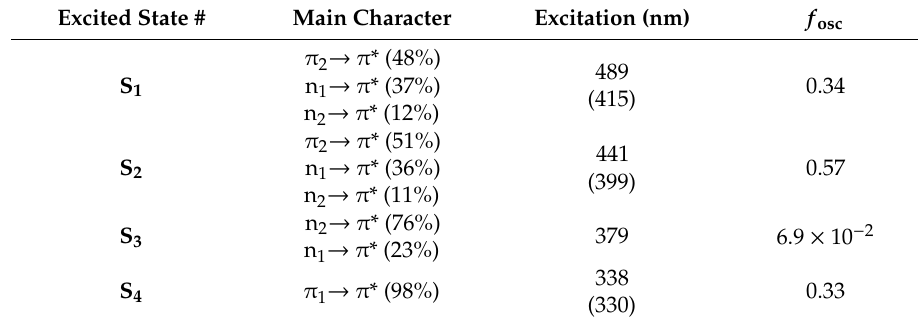
Table 3. Calculated excitation energies, band maxima assignments and oscillator strengths ( f osc ) of E -AZO1 (experimental values from UV / Vis analysis are shown in brackets).